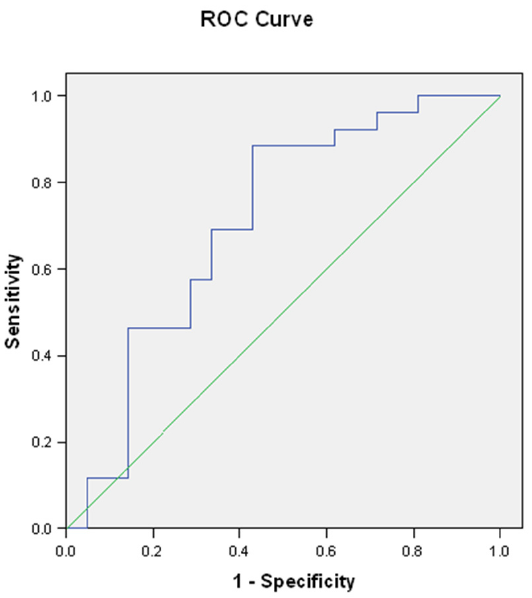
Figure 2. ROC curve for calumenin as diagnostic test for diffuse cutaneous fibrosis. AUROC = 0.70, 95% confidence interval 0.56–0.86.